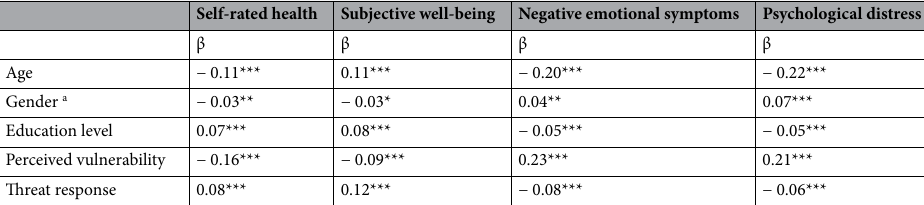
Self-rated health Subjective well-being Negative emotional symptoms Psychological